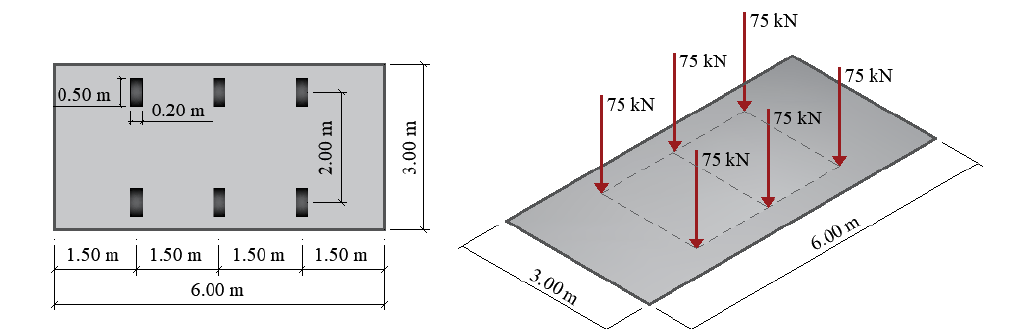
Figure 5. Vehicle type TB-450. Adapted from ABNT NBR 7188 [15].